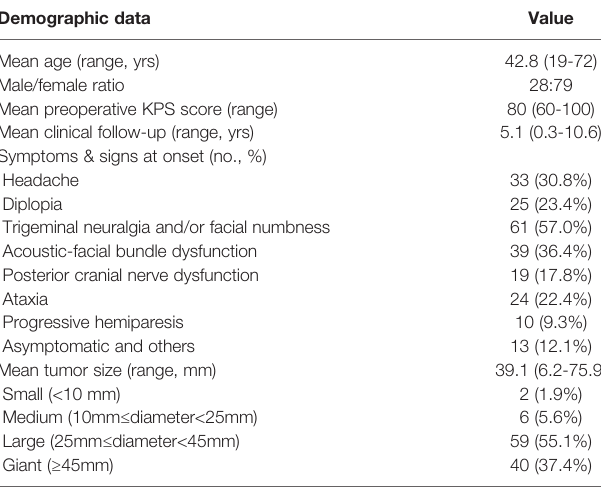
TABLE 2 | Demographic data for 107 patients with petroclival